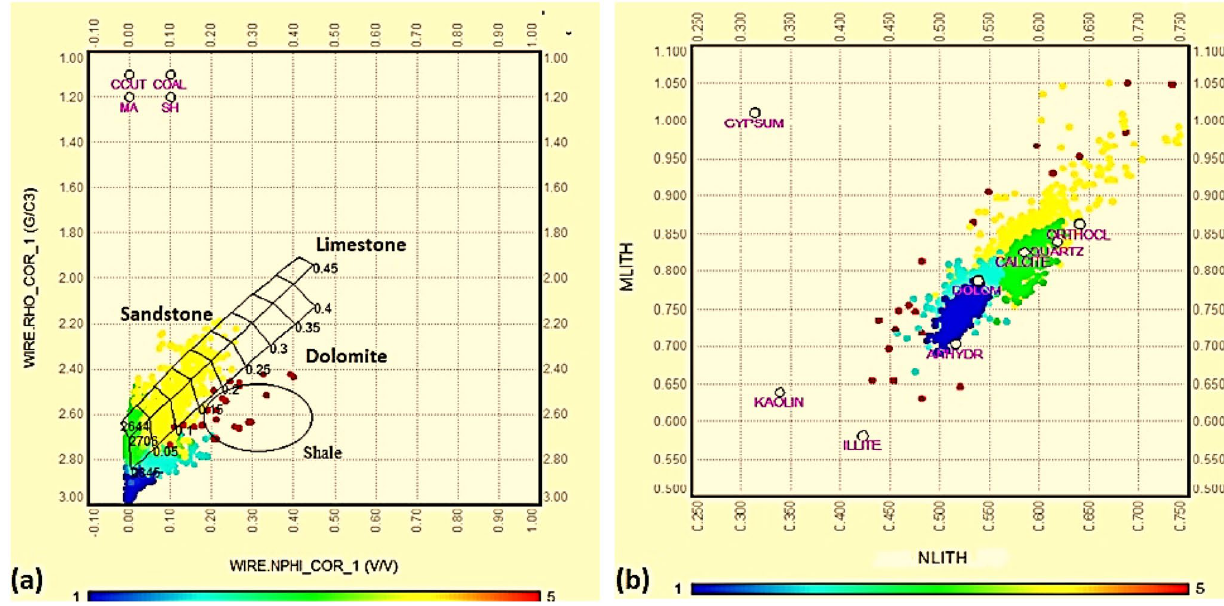
Fig. 7 a Cross-plot of neutron versus density logs. In this plot, each line shows a unique lithology. The numbers on the parallel lines indicate the amount of porosity. b Cross-plot of M/N. This plot determines the lithology of the facies according to the location of the